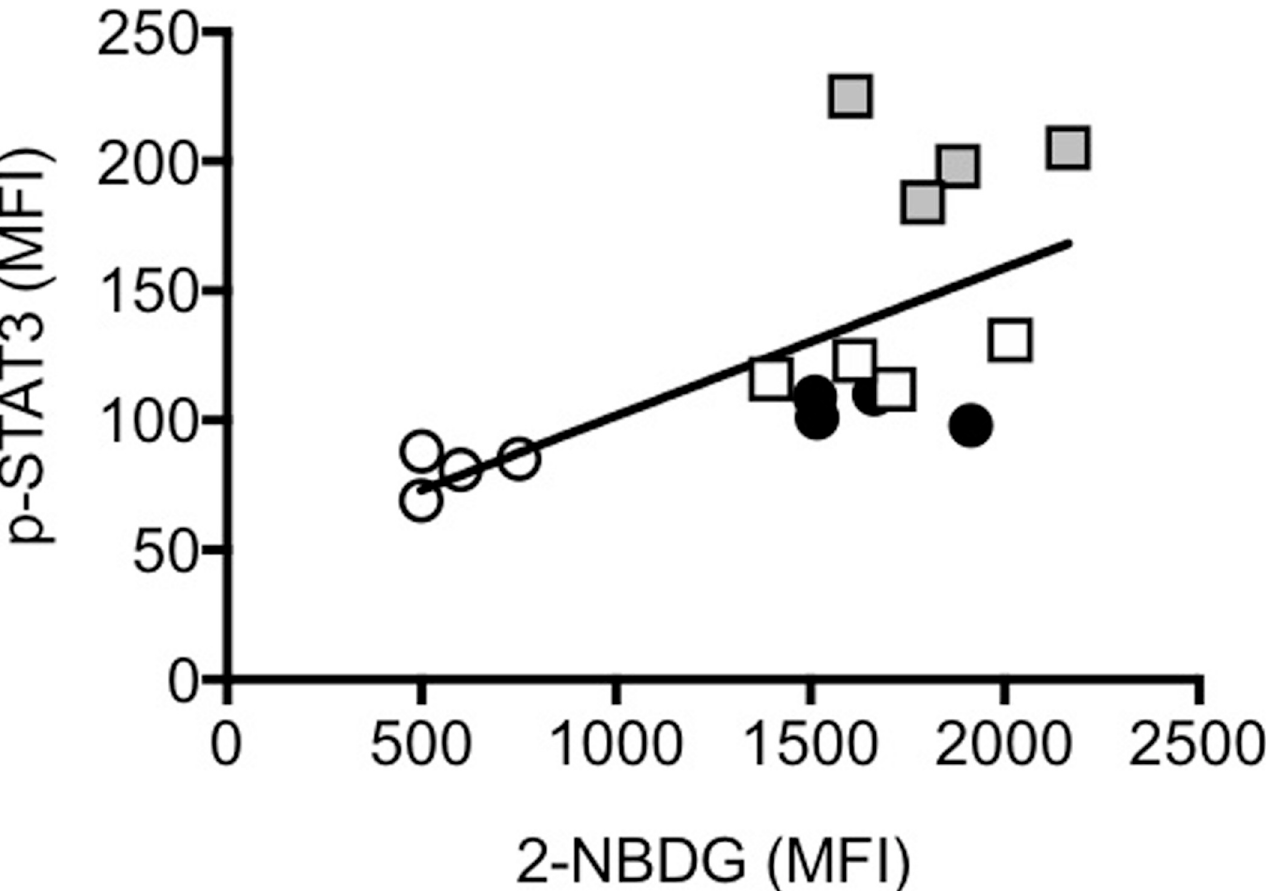
Fig 8. Glucose uptake is positively associated with ic phospho-STAT3 in DN B cells. PBMC and SVF were obtained as indicated previously. Glucose uptake and ic phosphor-STAT3 were measured in DN B cells from the same individuals. Pearson’s correlation r = -0.65, p = 0.007. Symbols are as follows: young lean, white circles; elderly lean: black circles; young obese: white squares; young obese SVF: grey squares.